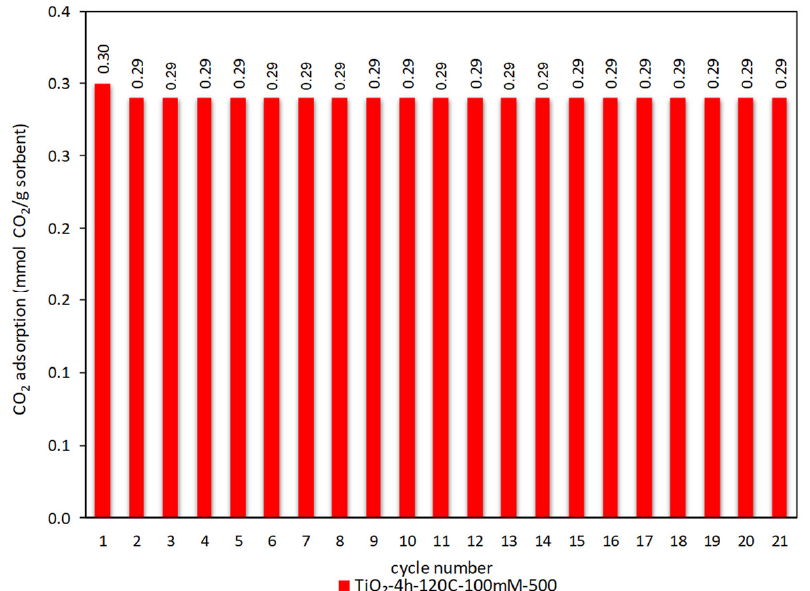
Figure 7. Cyclic stability of CO 2 adsorption-desorption for a TiO 2 -4 h-120-100 mM-500 sample at 30 °C.